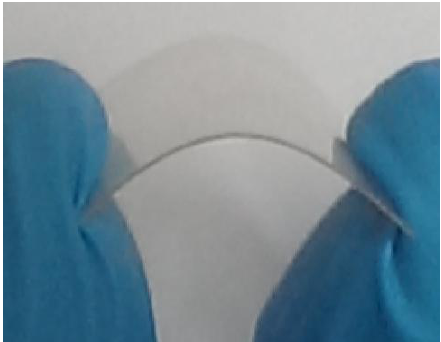
Figure 11. The flexible GO-doped PVDF